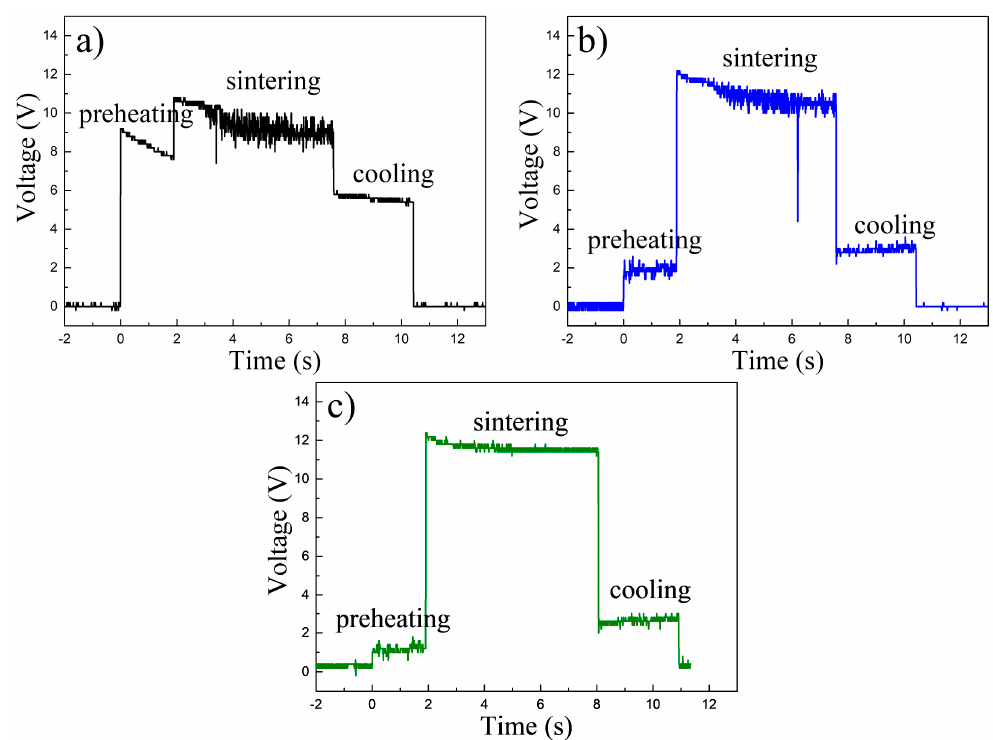
Figure 2. Voltage profiles with three processing steps of ( a ) sample UFS 1, ( b ) sample UFS 2 and ( c ) sample UFS 3.